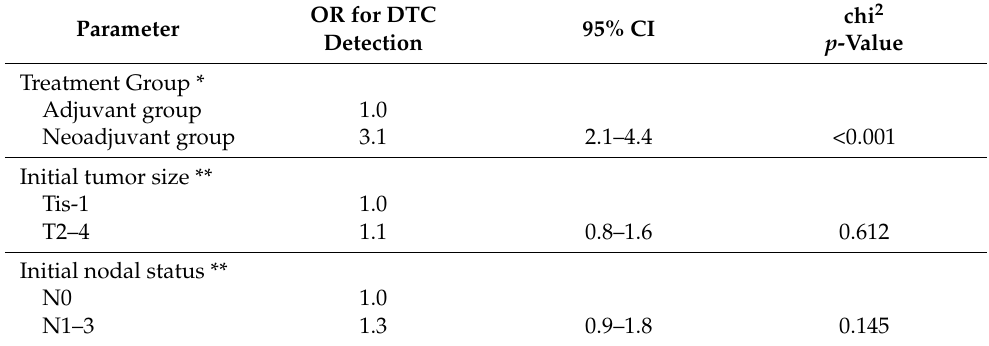
Table 4. Nominal logistic regression of factors influencing disseminated tumor cell (DTC)